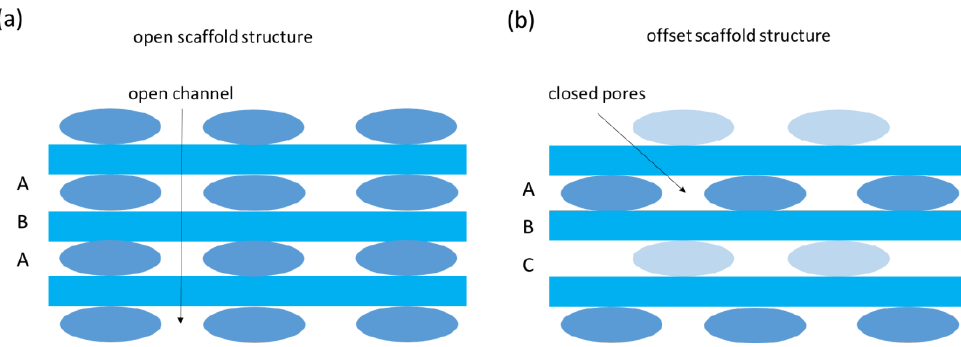
Figure 1. Sketch of 3D printed ( a ) scaffold structure and ( b ) offset scaffold structure. An open scaffold structure (scaffold) consists of an ABA layer organization. Using